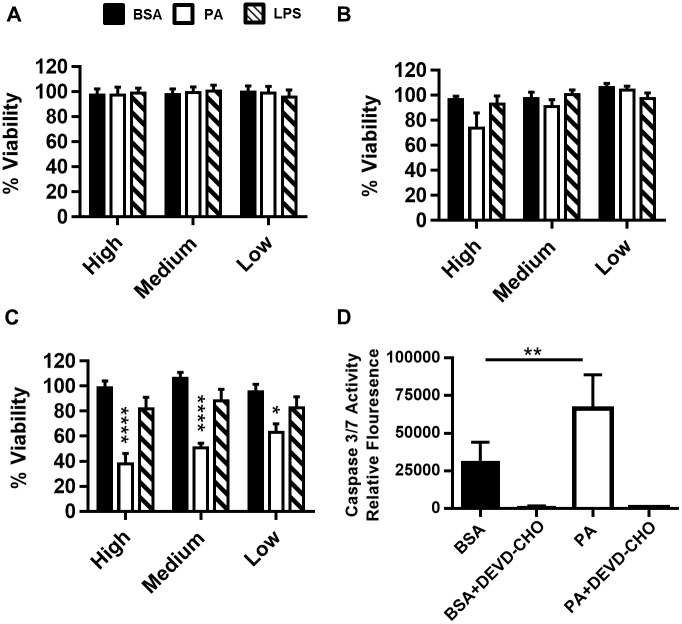
Dendritic cell viability following high (300μM), medium (150μM) and, low (75μM) dose PA treatment.MoDCs were inoculated with PA in a 2:1 molar ratio with BSA for (A) 12 hrs, (B) 24 hrs, or (C) 48 hrs. The cells were analyzed for loss of viability by flow cytometry using Annexin V and propidium iodide (PI) staining. LPS was used as a positive control to assess MoDC activation. The data is represented as the percent of total MoDCs negative for both Annexin V and PI normalized to the BSA negative control. (D) PA induces caspase 3/7 activity. MoDCs were treated with PA complexed 2:1 with BSA for 36 hrs. Caspase 3/7 activity was measured by the emitted fluorescence of cleaved DEVD-AMC. N = 3. Statistical analysis was calculated based on One way ANOVA (** = p<0.01, *** = p<0.001, **** = p<0.0001).